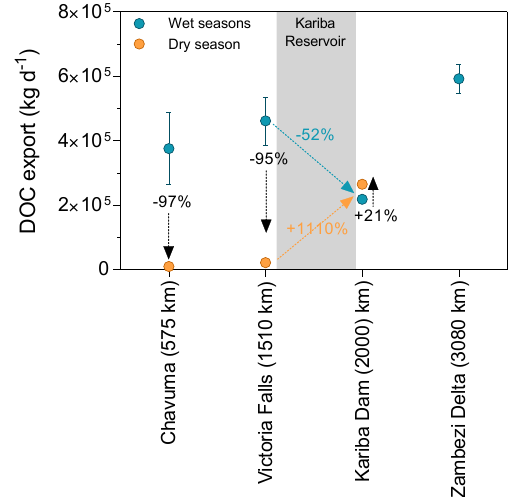
Figure 8. DOC exports calculated at different locations along the Zambezi River during the wet and the dry seasons. Vertical arrows represent changes in DOC exports at the same location between wet and dry seasons. Diagonal changes represent longitudinal vari-